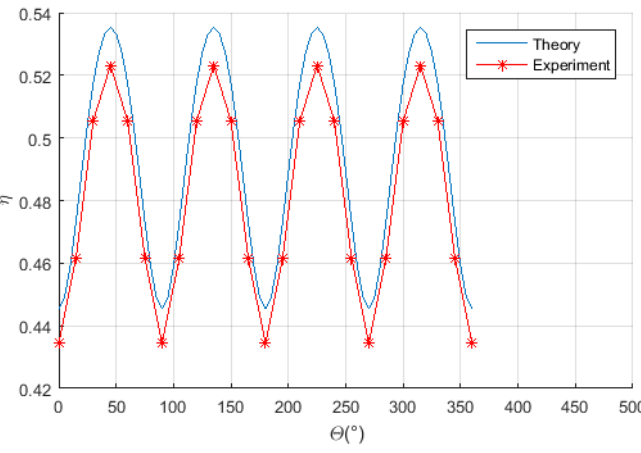
Figure 14. The power transfer efficiency versus the receiving coil moving along the solid line. When the center location and posture of the receiving coil are adjusted at (90°, 45°) (which indicates the point (0.28 m, 0.28 m, 0 m) in {A}) and (0, 90°, 45°) shown in Figure 15a, the phase-shifted drive pulses of MOSFET must be set using Figure 15b, where CH1, CH2, CH3 and CH4 represent standard drive pulses, phase-shifted drive pulses of excitation source 1, 2 and 3, respectively. Then the input voltage and current, output voltage and current waveforms are measured by CH1, CH2, CH3 and CH4 shown in Figure 15c.